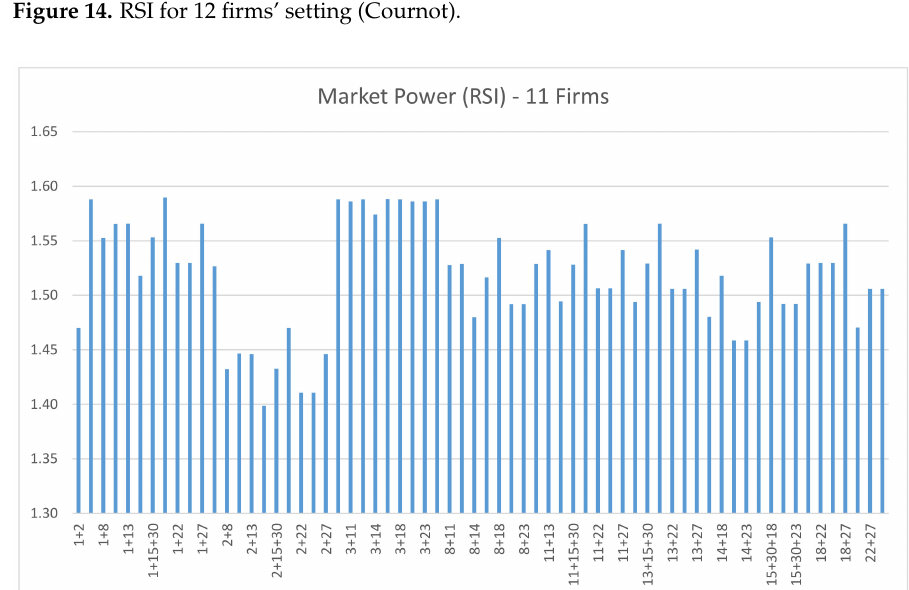
Figure 15. RSI for 11 firms’ setting